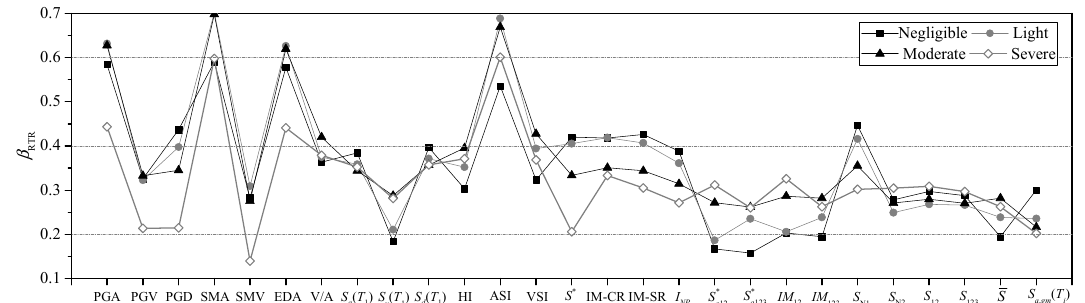
Figure 7. Fragility curves characterized by S a ( T 1 ) for the four damage limit states in cases of near- field set.